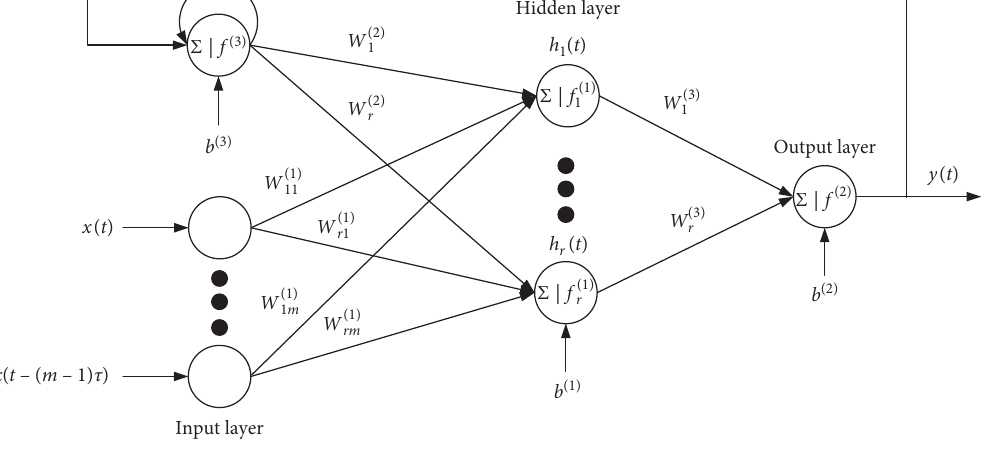
Figure 1: Jordan neural network